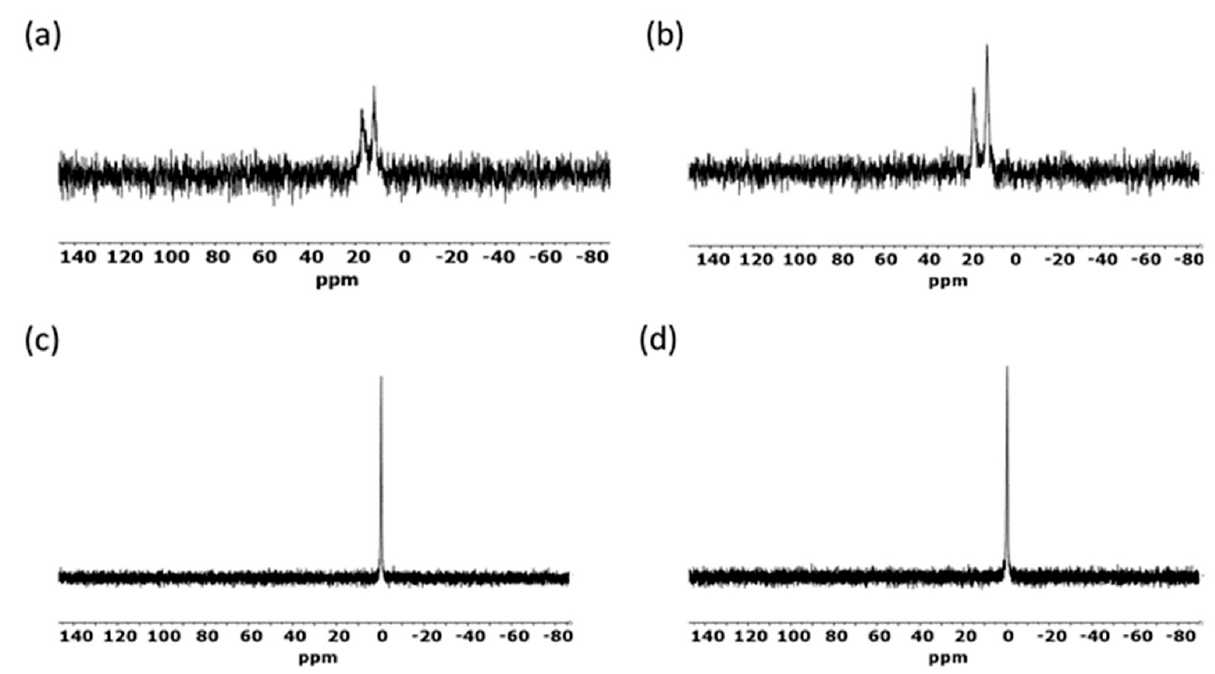
Figure 3. 31 P{ 1 H} NMR spectra of PDI metal complexes ( a ) PDI-3 , ( b ) PDI-7 , ( c ) PDI-4 , ( d ) PDI-8 in CD 2 Cl 2 at 25 °C.